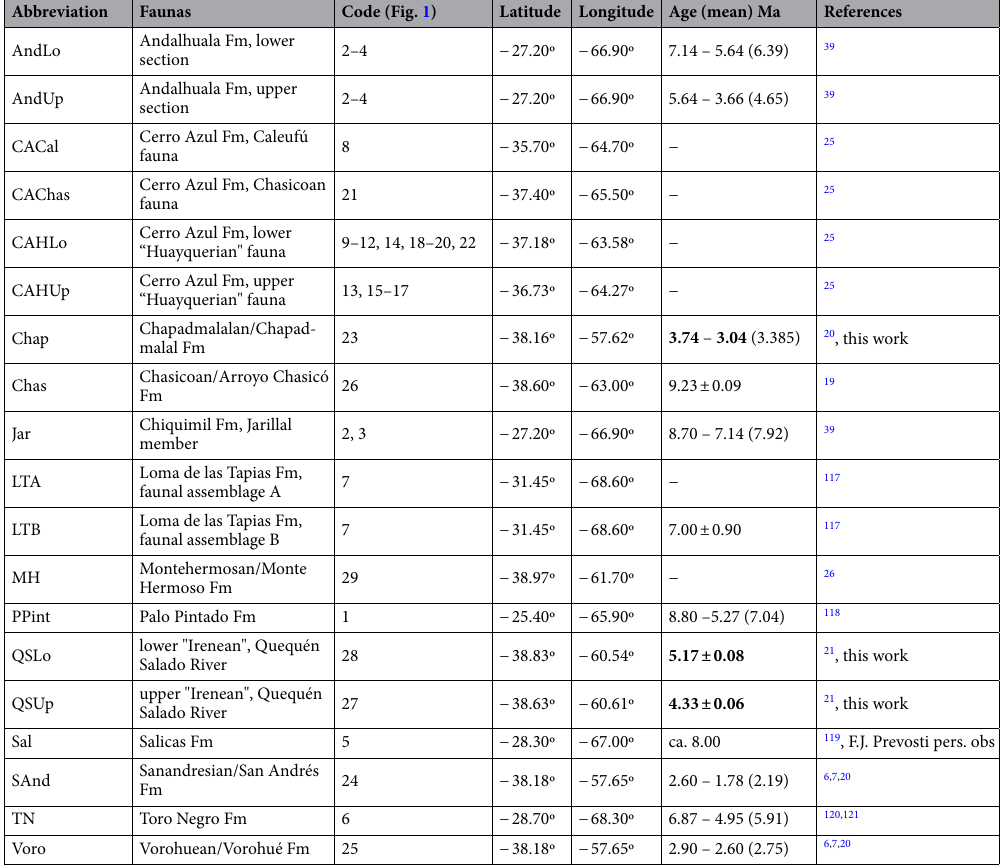
Table 1. Geochronological dates (new in bold) for referenced faunas from southern South America and main references. When more than one locality is noted for a fauna, the mean geographic coordinates are presented. When a locality has dates for its upper and lower limit, the midpoint is reported in brackets and is used for regressions. Age (Ma, million years before present) corresponds to radioisotopic dates, with the exception of Voro and SAnd which are based on paleomagnetic studies 20